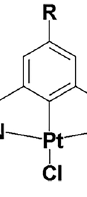
Figure 1. Molecular structure of the viscosity and oxygen sensitive Pt(II) complex of the cyclometalating, terdentate, N^C^N-coordinating ligand 1,3-Di(2-pyridyl)benzene, where R = H 20,21,24